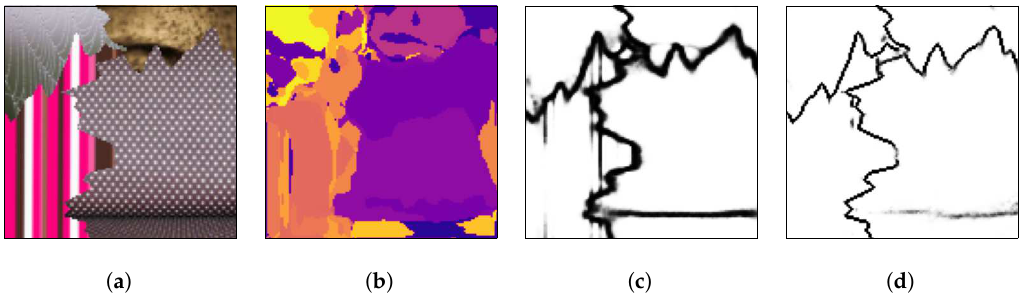
Figure 9. ( a ) An example mosaic, ( b ) the results of a multi-class labeling approach, ( c ) a HED architecture, and ( d ) the proposed method.